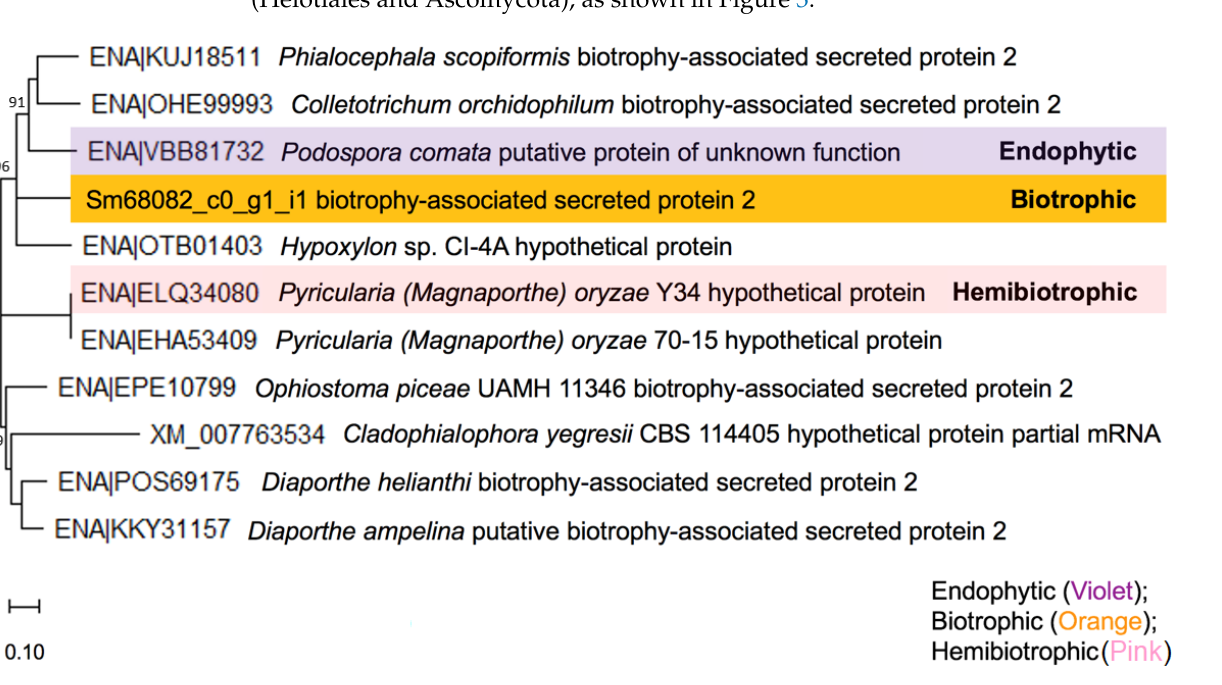
Figure 3. Phylogenetic tree of the transcript related to the biotrophy-associated secreted protein in S. mycoparasitica . The branch support bootstrap values were obtained by 1000 replicates using the NJ